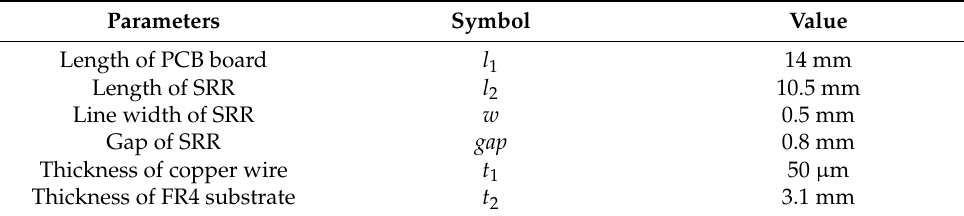
Table 1. Design parameters of the optimal